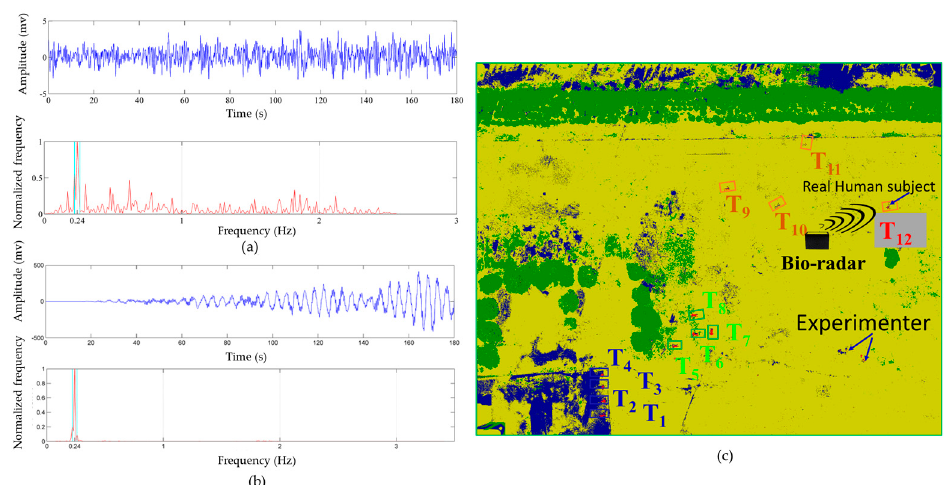
Figure 16. Radar echo of human target T 12 from 8 m and corresponding frequency analysis, ( a ) original signal and normalized frequency spectrum, ( b ) noise cancellation signal and normalized frequency spectrum, ( c ) human target reconfirmation result.